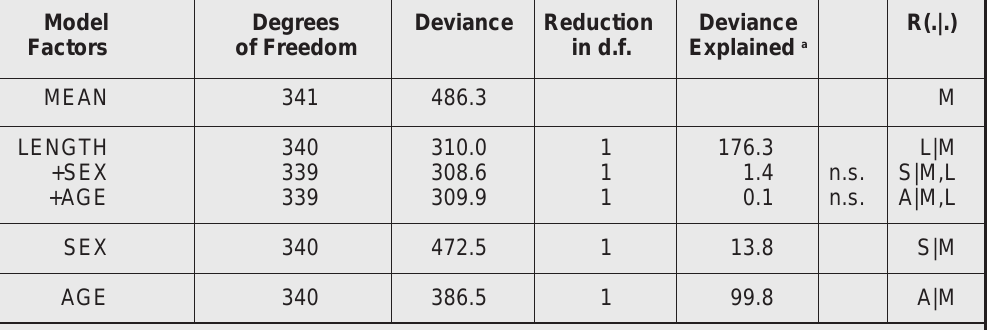
Table 4. Analysis of deviance to model effects of age, sex and length to explain variability of log worm counts from grey seals taken in 1989. All models use an identity link and normal error dis- tribution. The amount of deviance explained by factor B is given that factor A is already in the model as indicated by R(B|A).